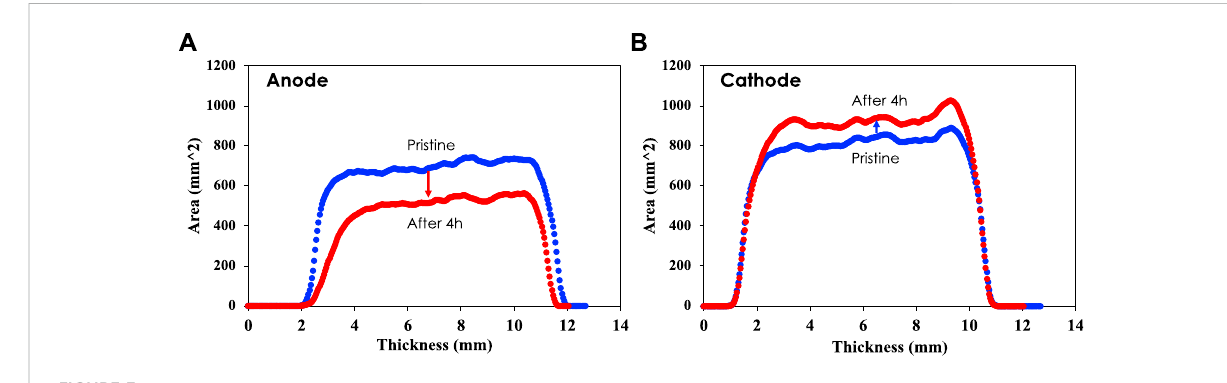
FIGURE 3 3D image analysis providing the area of each electrode vs. thickness of the anode (A) and cathode (B) .